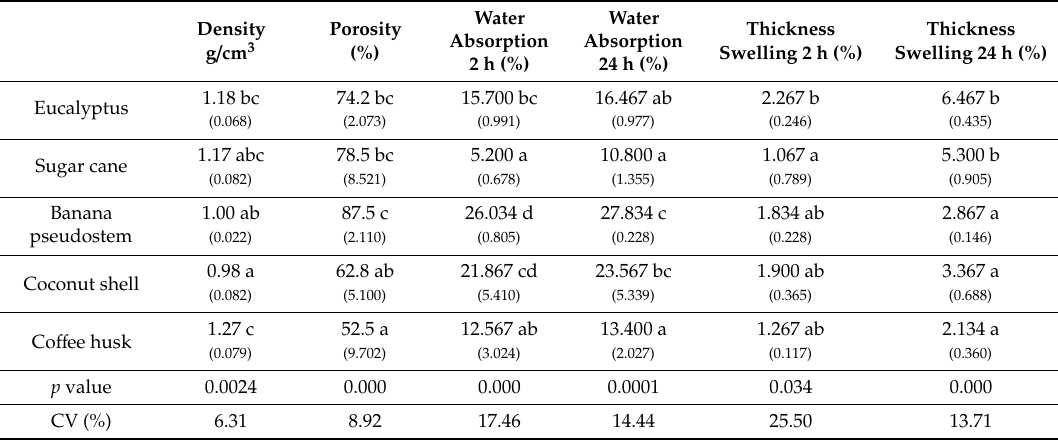
Table 3. Average and standard deviation of the physical properties of the lignocellulosic